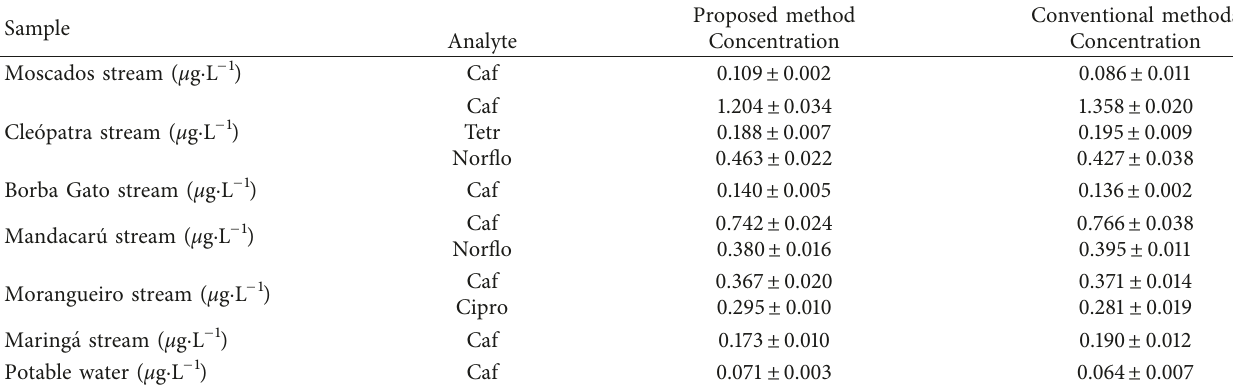
Table 4: Analyte determination by the proposed and conventional